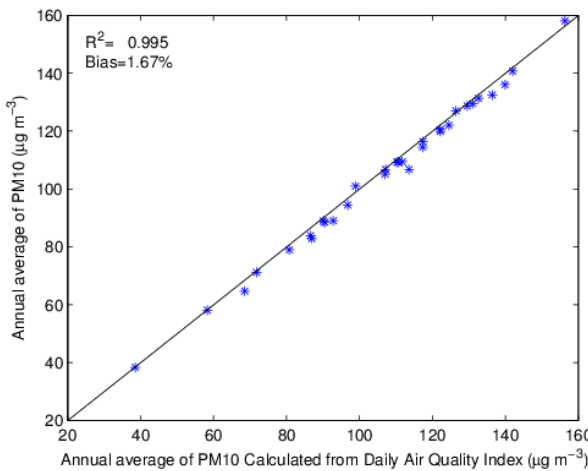
Fig. 3. The comparison of site-average PM 10 calculated from Air Figure 3. The comparison of site-average PM10 calculated from Air Quality Index Quality Index and those averaged from PM 10 measurements from and those averaged from PM10 measurements from 2003 to 2009 in 31 major 2003 to 2009 in 31 major cities in cities in China.